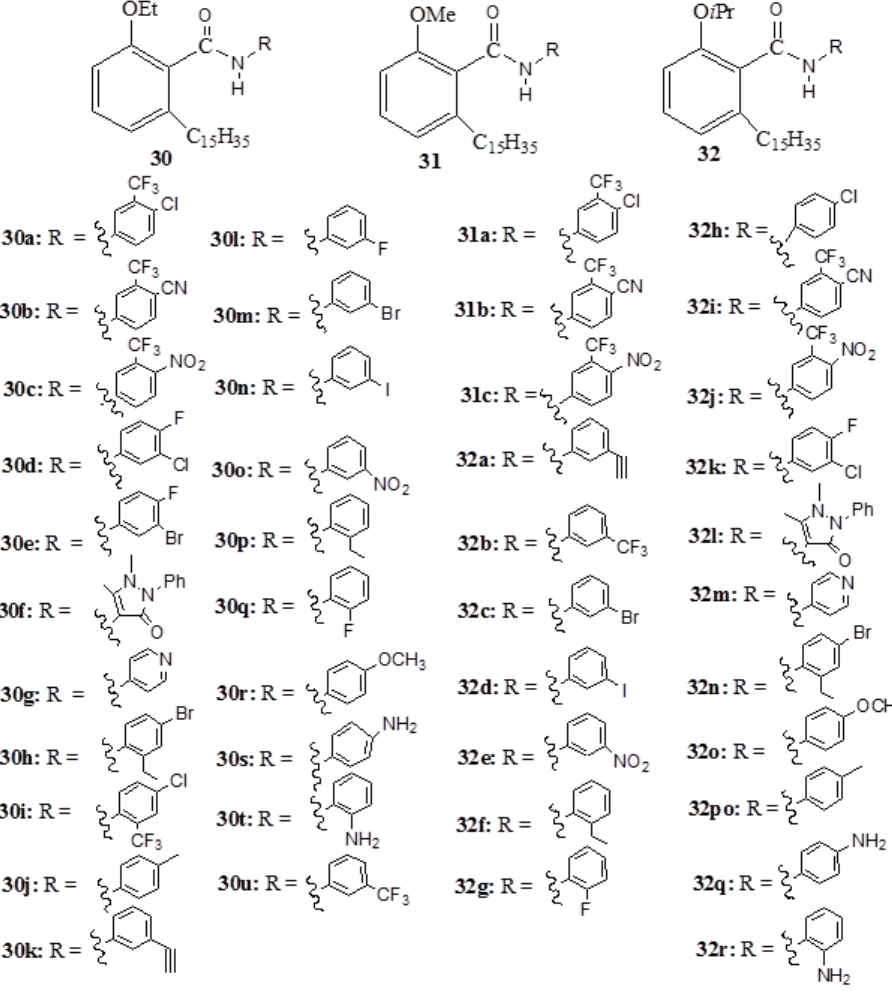
Figure 12. The amide derivatives ( 30 – 32